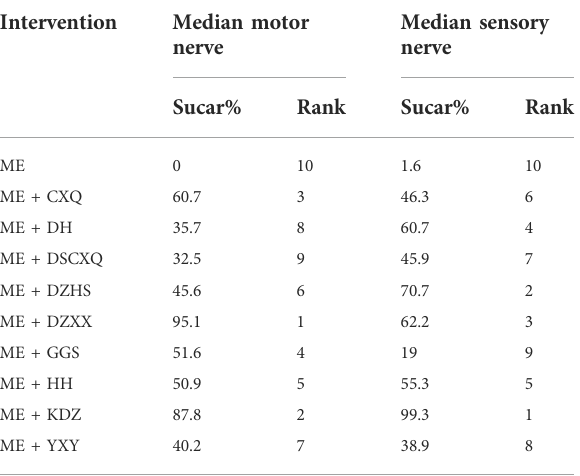
TABLE 5 The cumulative ranking probabilities (SUCRA) results of median nerve. Intervention